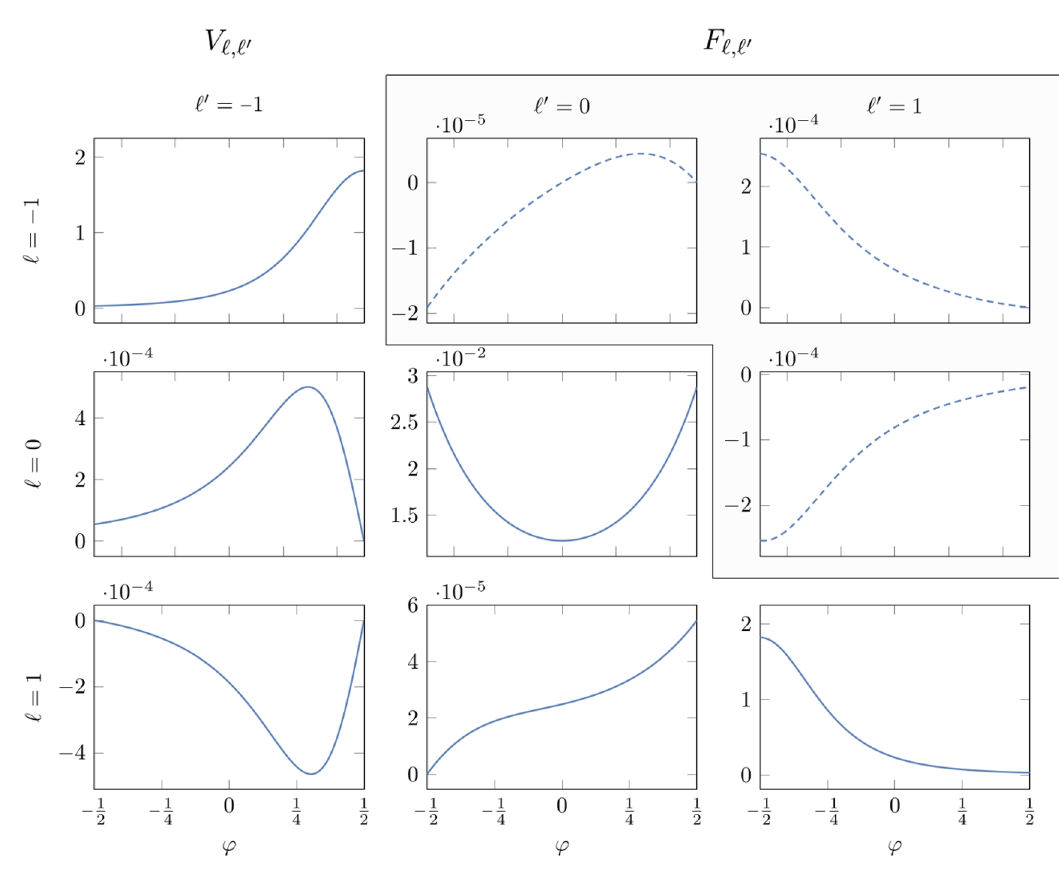
Figure 13. V ‘;‘ 0 (bottom left panels) and F ‘;‘ 0 (top right panels) for N = 3 and q 3 = 1 = 2, where we suppress the band labels n and n 0 . Solid lines represent real-valued potentials and dashed are purely imaginary. The V ‘;‘ 0 and F ‘;‘ 0 are plotted in units of ~ 2 = (2 f 2 ) and ~ =f 2 ,